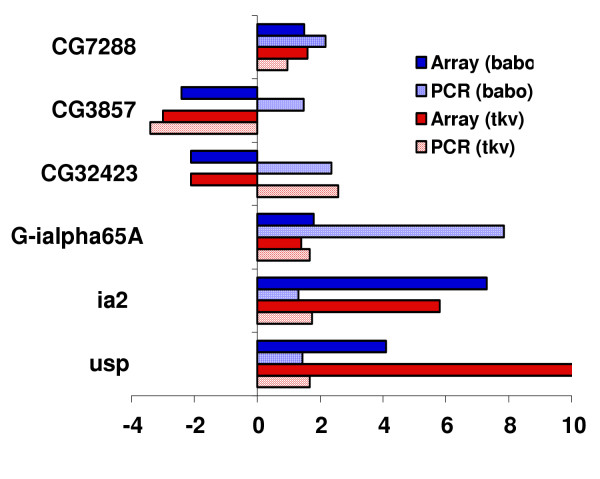
Validation of microarray data by real time RT-PCR. The X-axis indicates fold changes (FC) of gene expression levels between tkv/babo ectopic expression and control (Positive values indicate that the relative expression level of a gene is increased and negative values indicate a decrease). Array /PCR (tkv, babo) represents the fold changes of transcripts with ectopic expression of tkv, babo in microarray /Real time PCR respectively.